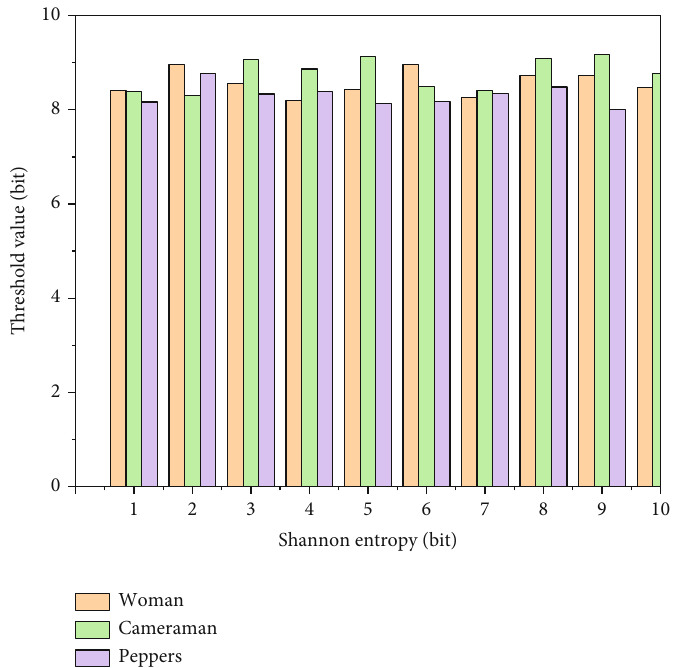
Figure 4: Shannon entropy and local Shannon entropy